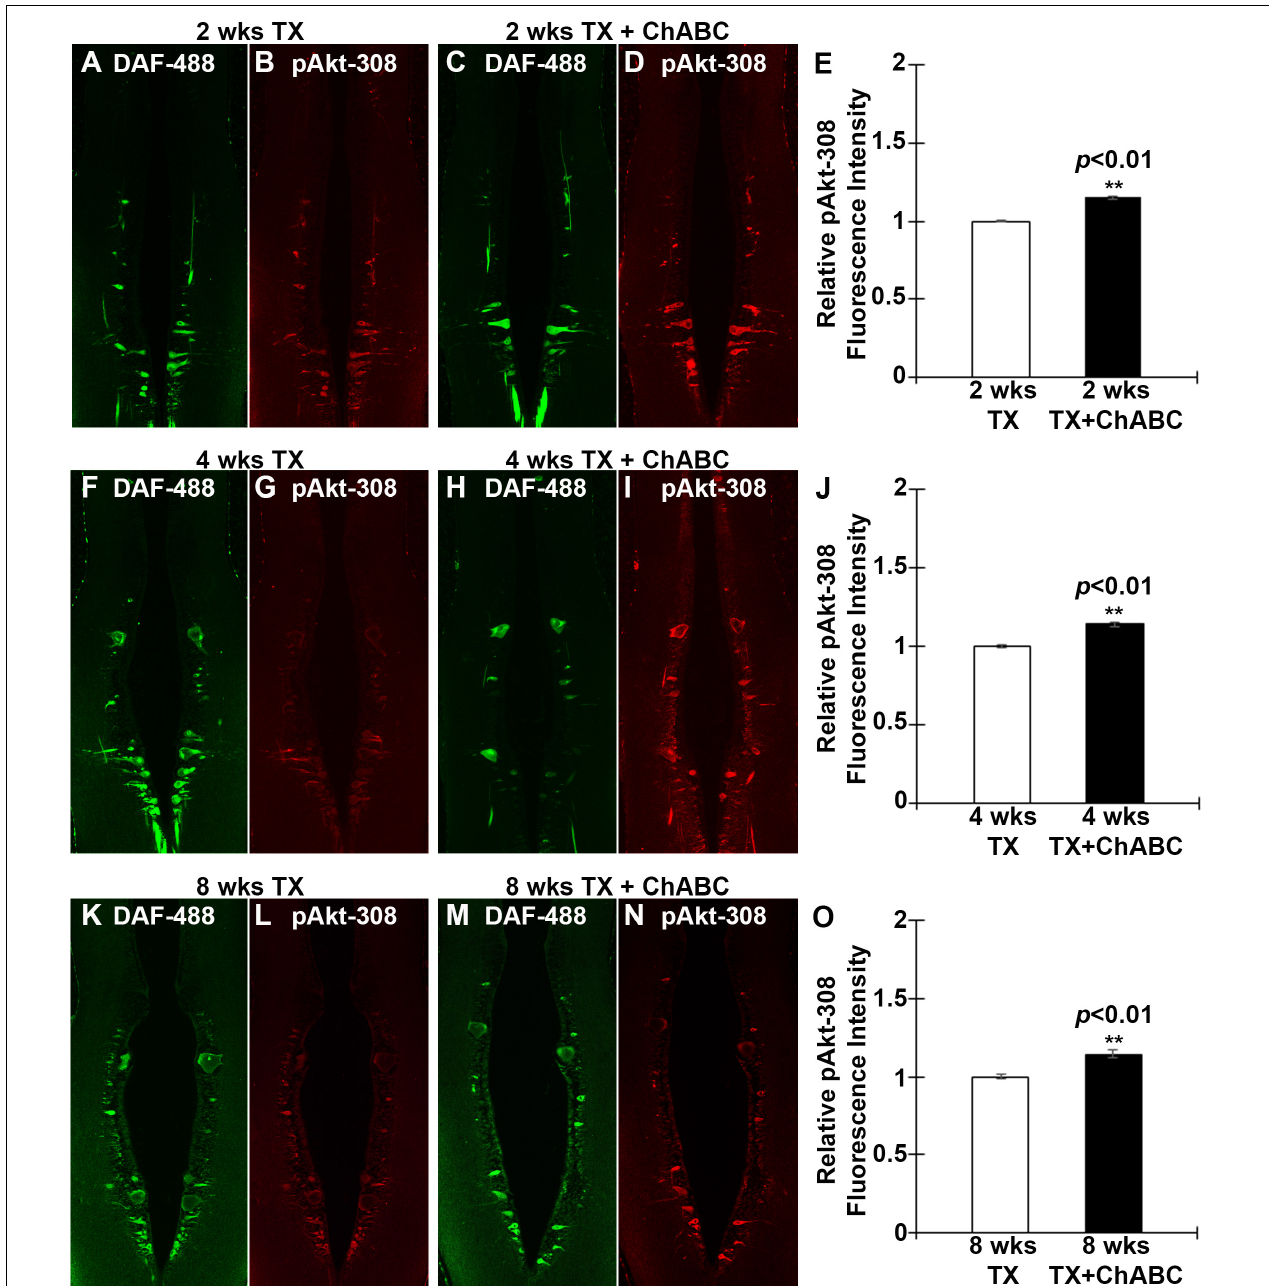
FIGURE 7 | ChABC treatment increases the axotomy-induced activation of Akt in identified RS neurons. RS neurons were retrogradely labeled with DAF-488 and treated with ChABC or control enzyme buffer. Horizontal paraffin sections were prepared and imaged at 2 weeks post-TX (green, A and C ). Sections were immunostained for pAkt-308 (Red, B and D ). There was a small but statistically significant increase in pAkt-308 fluorescence intensity in identified RS neurons of the ChABC-treated group, relative to the control buffer-treated animals, whose mean intensity was defined as 1 ( E ; ** p < 0.01, n = 3 lampreys per group). This also was true at 4 weeks ( F–J ; ** p < 0.01, n = 5 lampreys per group) and at 8 weeks post-TX ( K–O ; ** p < 0.01, n = 3 lampreys per group). Error bars: SEM. Scale bar: 100 µ